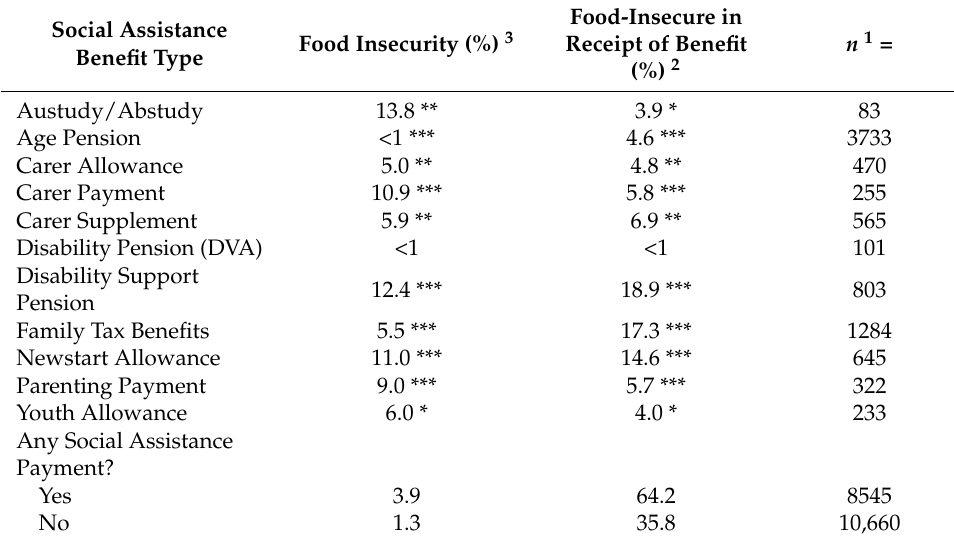
Table 2. Food insecurity prevalence and percentage receiving social assistance payments—persons, weighted (%),